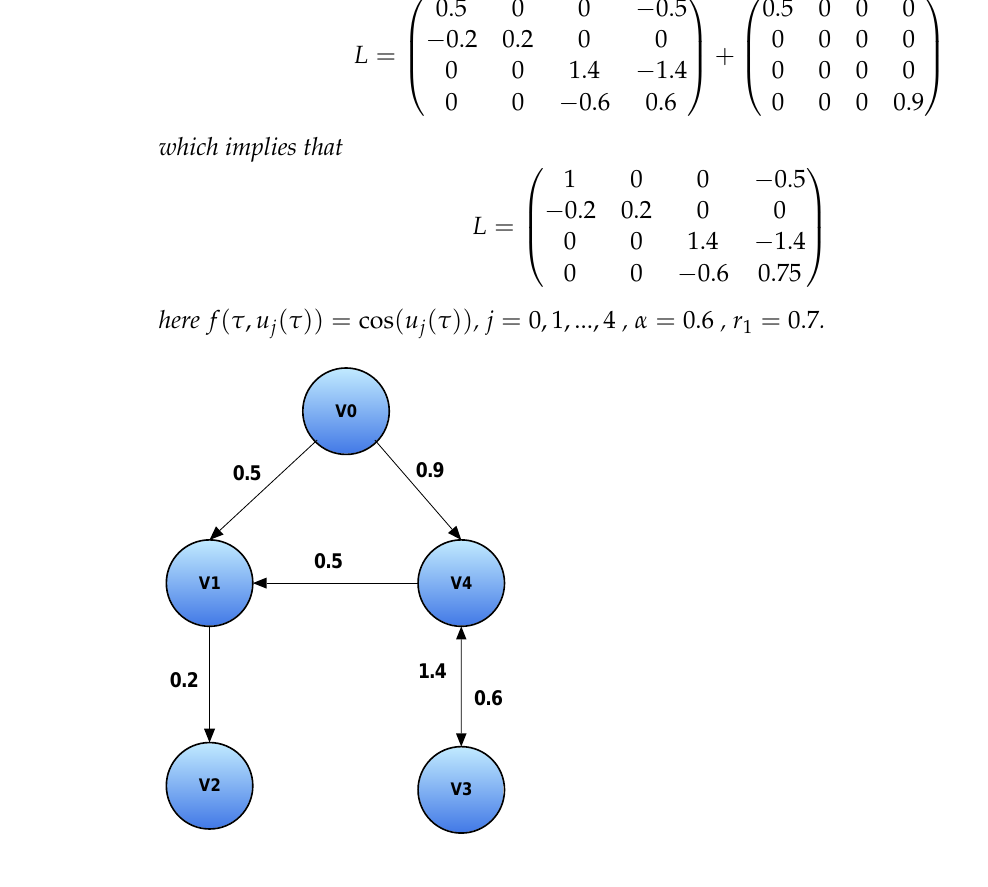
Figure 1. Directed spanning tree shown by nonlinear multi-agent system topology. Consider e = 0.3 by using assumption